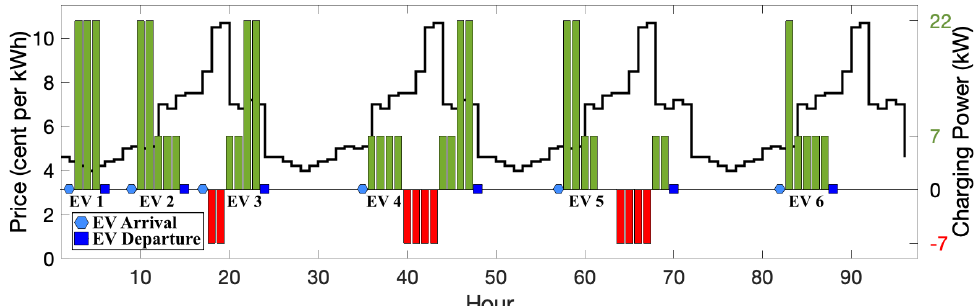
Figure 6. Charging and discharging times of EVs over 4